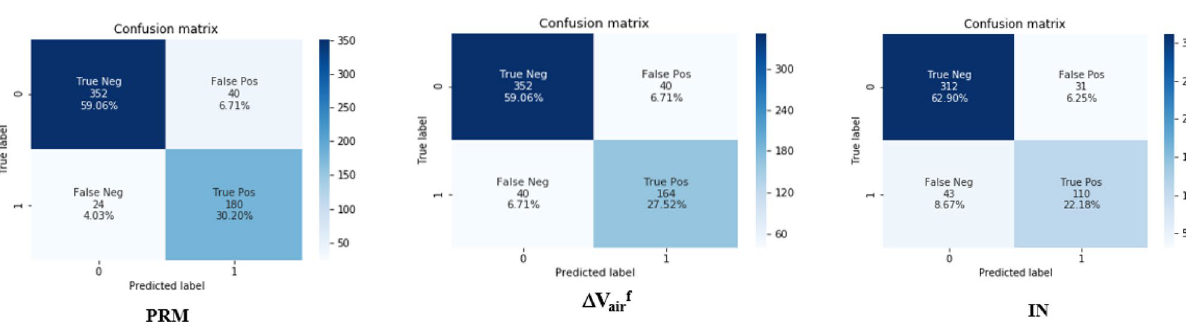
Figure 5. Confusion matrices of PRM, Δ V air f , and